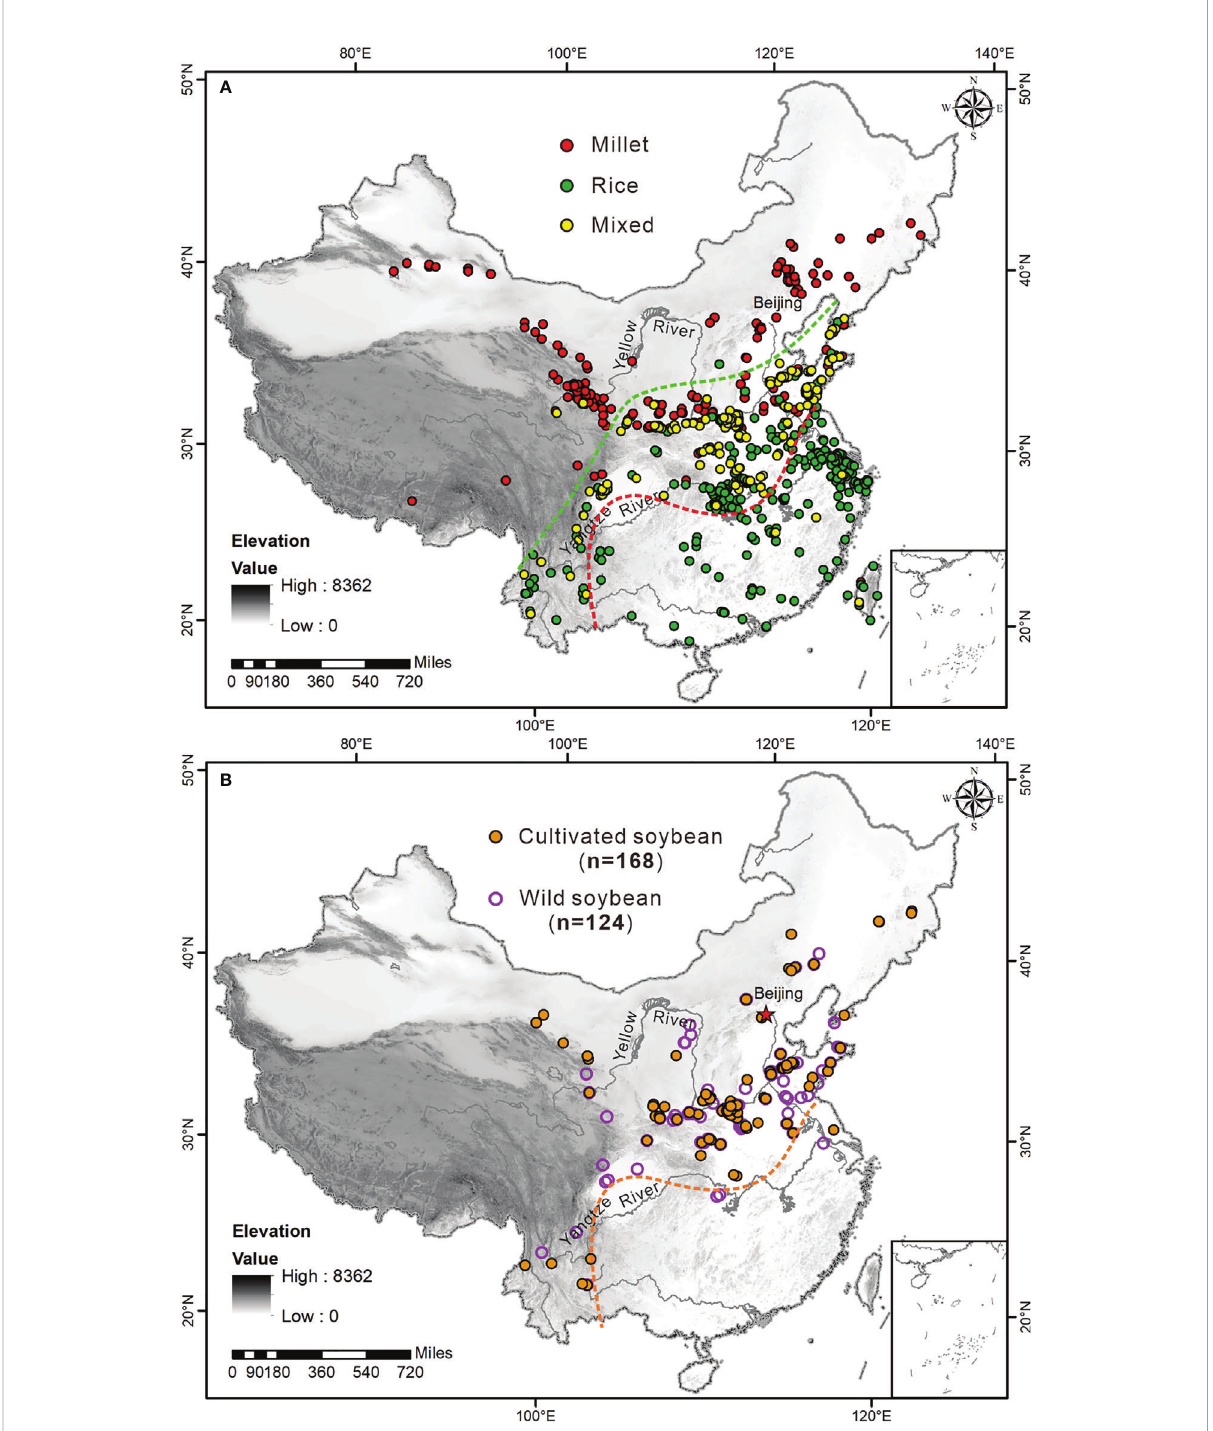
FIGURE 2 Distribution of staple cereals (millet and rice) (A) (He et al., 2017) and companion legumes (soybeans) (B) in the Neolithic and Bronze Age across China. The red, green and yellow solid circulars in (A) indicate sites of millet, rice and mixed farming, respectively. The orange solid and purple hollow circulars in (B) denote sites of cultivated and wild soybeans